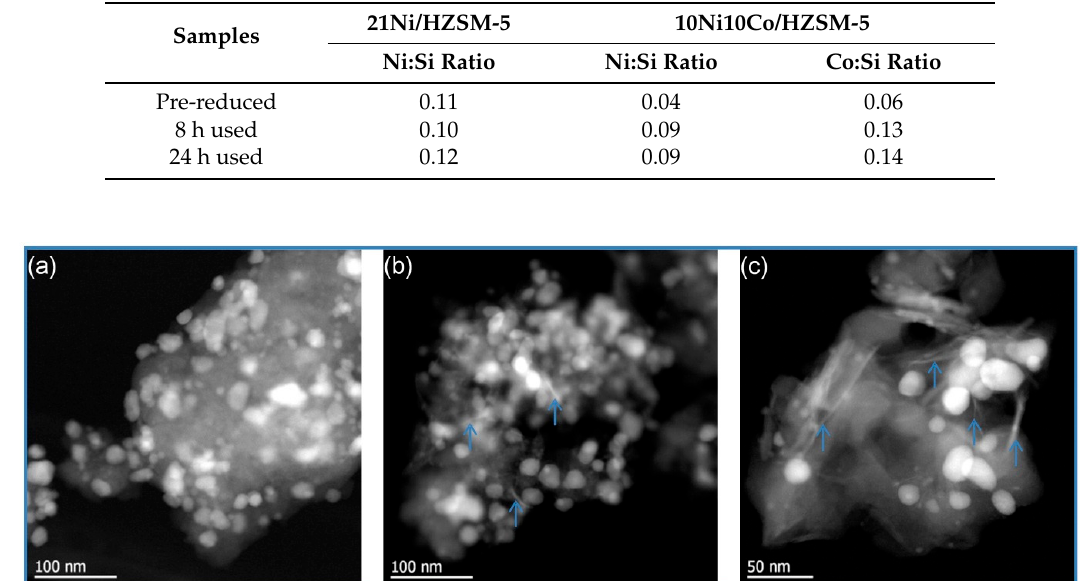
Figure 4. Transmission electron microscopy (TEM) images of 10Ni10Co/HZSM-5: ( a ) pre-reduced; ( b ) after 8 h on-stream and ( c ) after 24 h on-stream (arrows indicate the band-like particles).